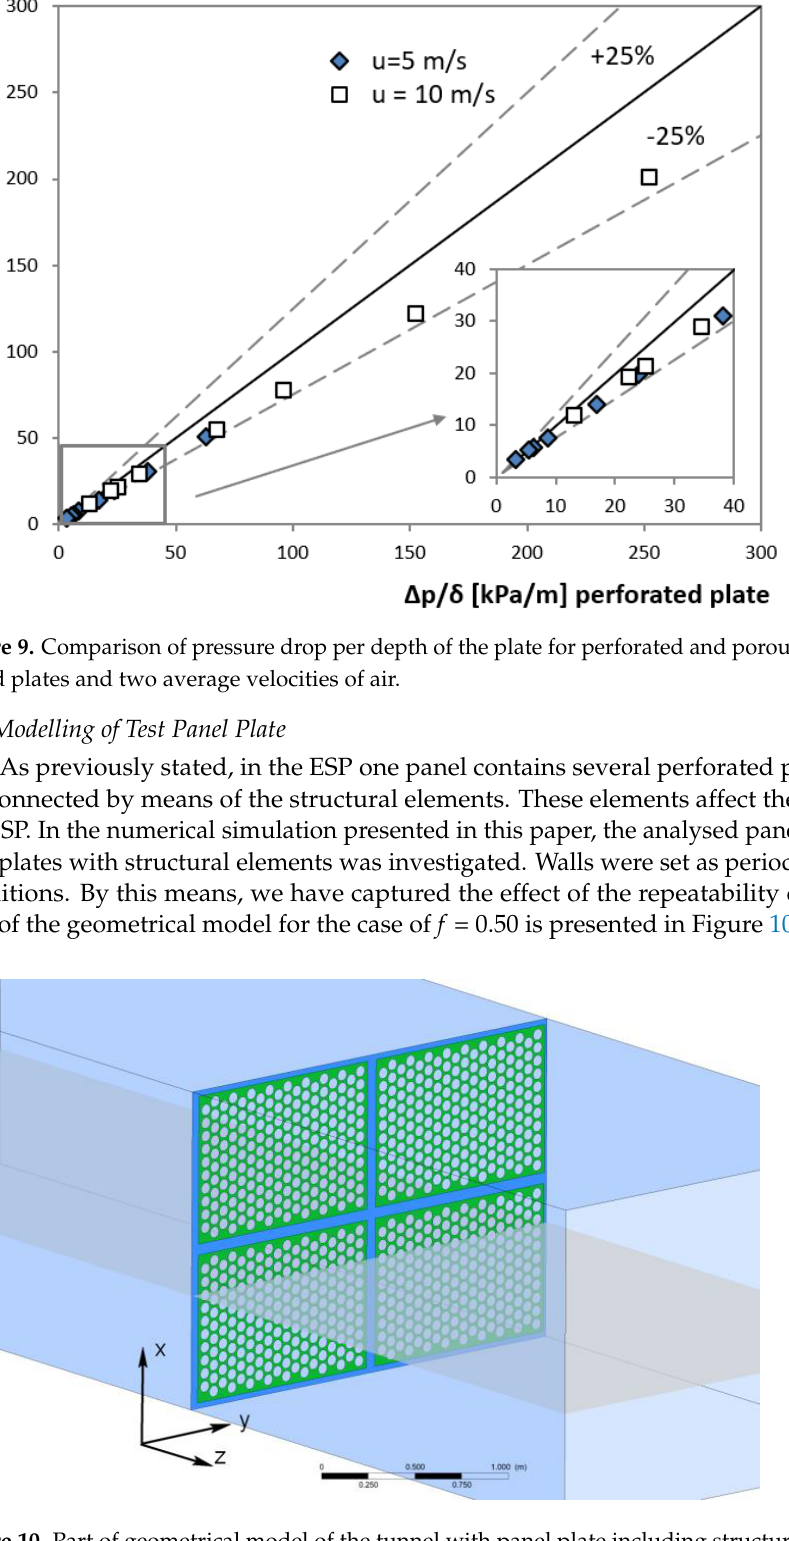
Figure 10. Part of geometrical model of the tunnel with panel plate including structural object; grey area represents the plane at x = 0.63 m.